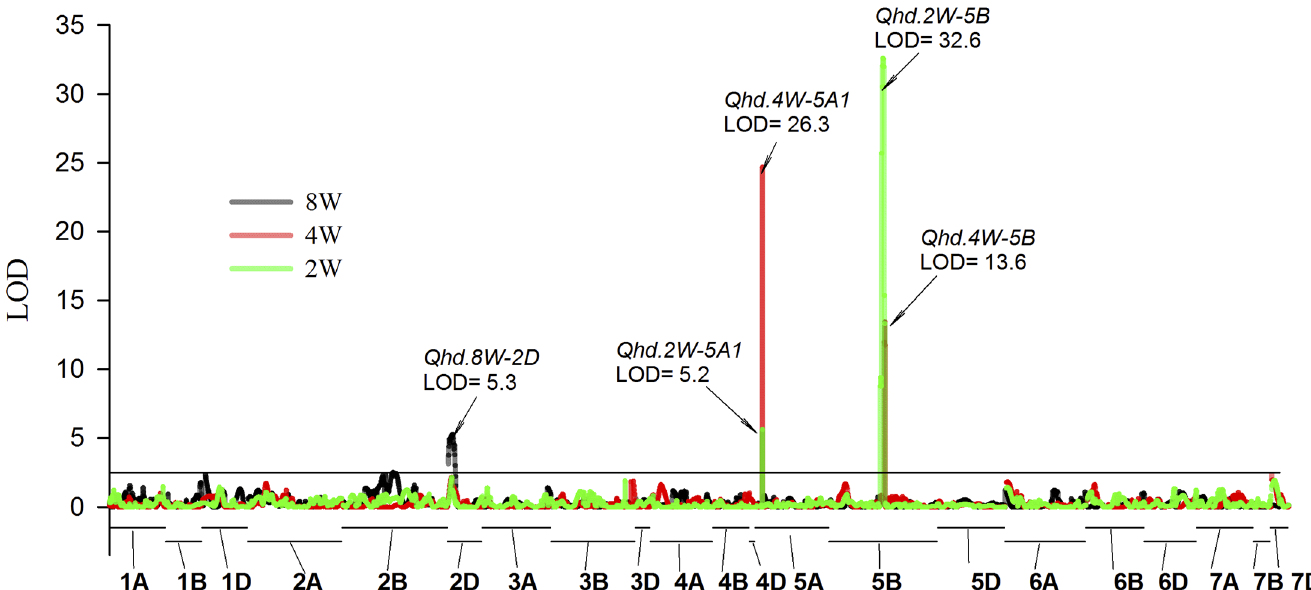
Fig 3. Greenhouse Manhattan plot. Genome scan of logarithm of the odds (LOD) scores for heading dates in AGS 2000 × 26R61 recombinant inbred lines in greenhouse experiments after 8 weeks; 8W, 4 weeks; 4W, and 2 weeks; 2W of vernalization treatment.